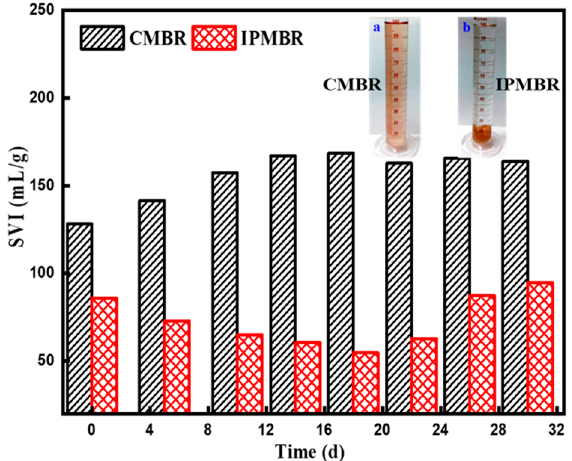
Figure 10. Variation of sludge volume index (SVI) of microorganisms with operation time in different MBRs and photographs of the microorganism in the CMBR ( a ) and IPMBR ( b ) systems.